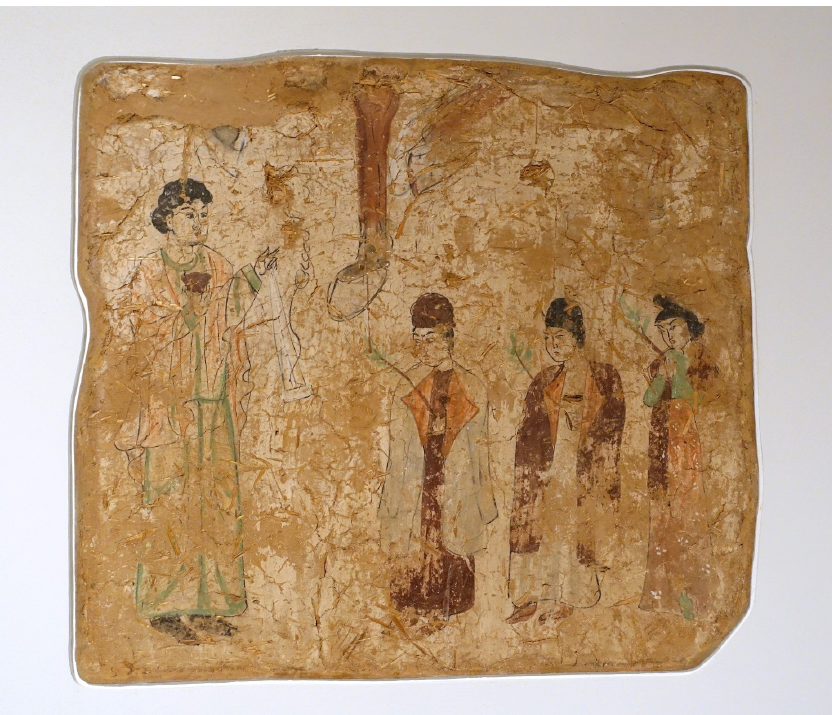
Figure 3 Palm-Sunday, Qocho, church 683–770 CE,